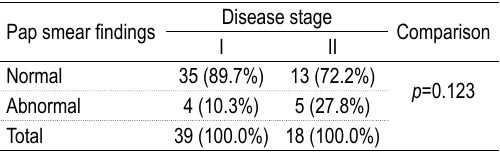
Table 3. relationship between the stage and the Pap